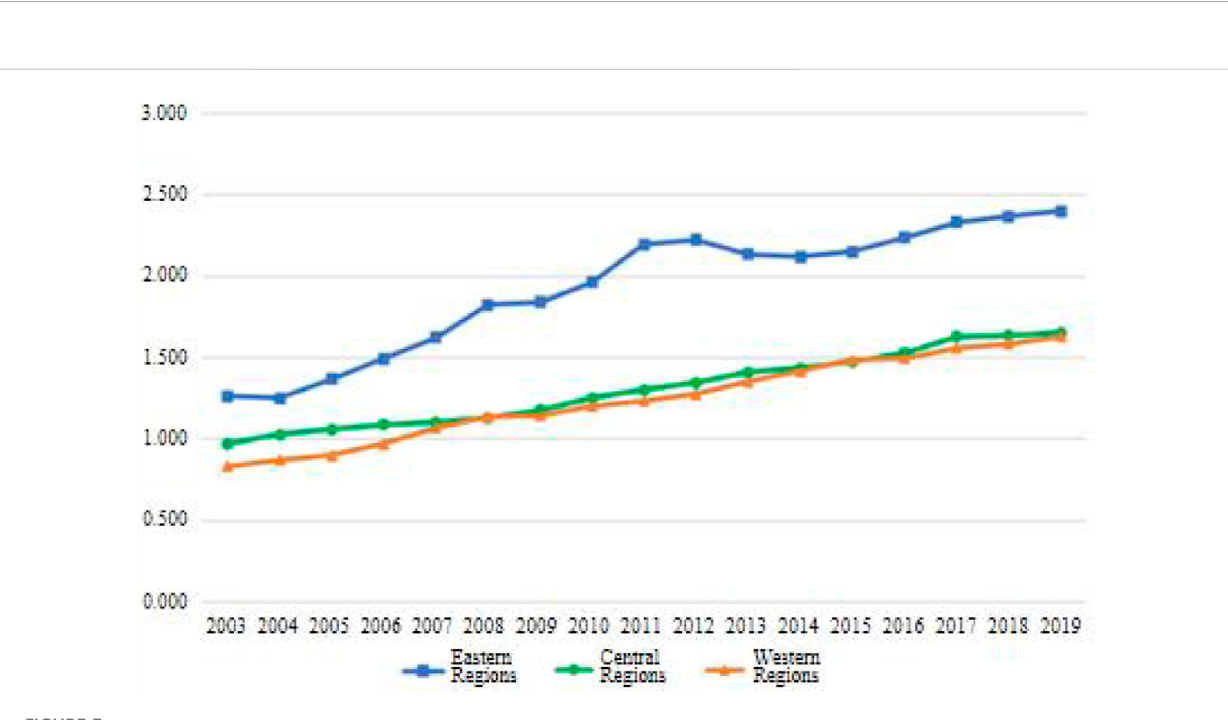
FIGURE 3 Comparison of the level of technical progress of non-energy factors in the service industry in the Eastern, central, and Western regions of